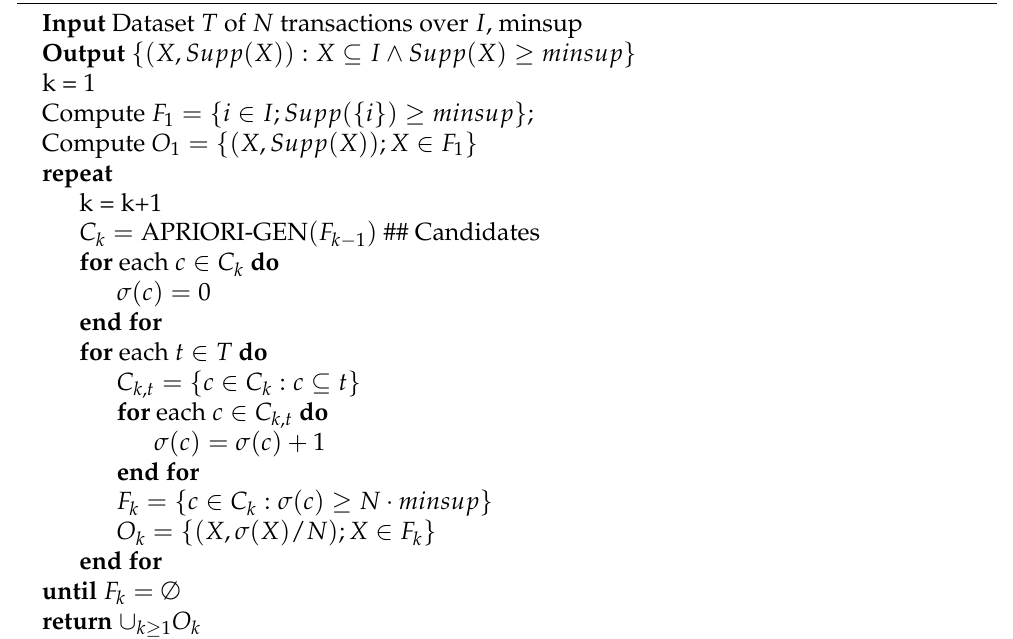
Algorithm 1 Apriori